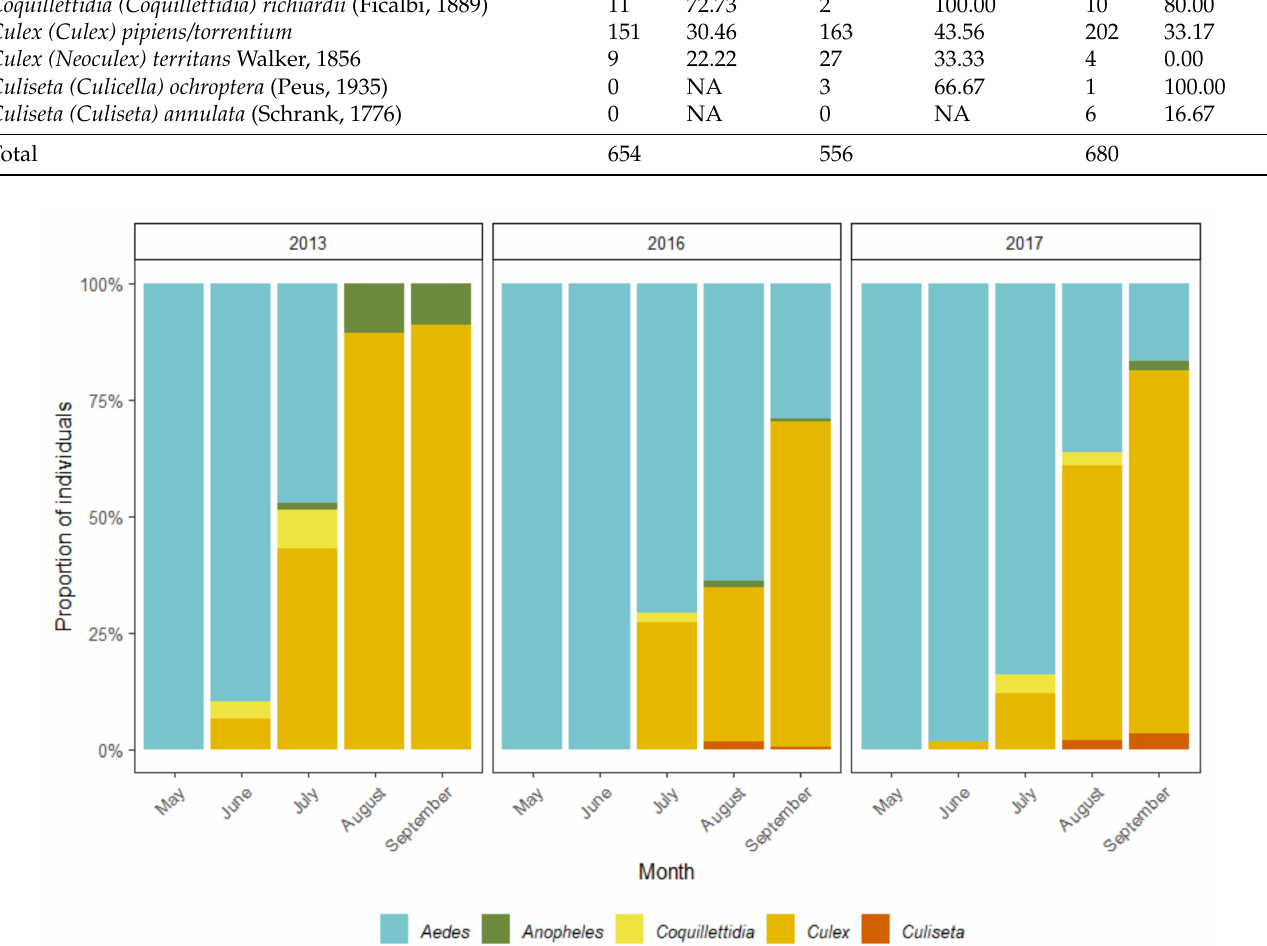
Figure 6. The succession of mosquitoes from different genera over the study period. The percentage of mosquitoes from five different genera collected in 2013, 2016 and 2017, showing the transition from Aedes to Culex dominated populations during the warm